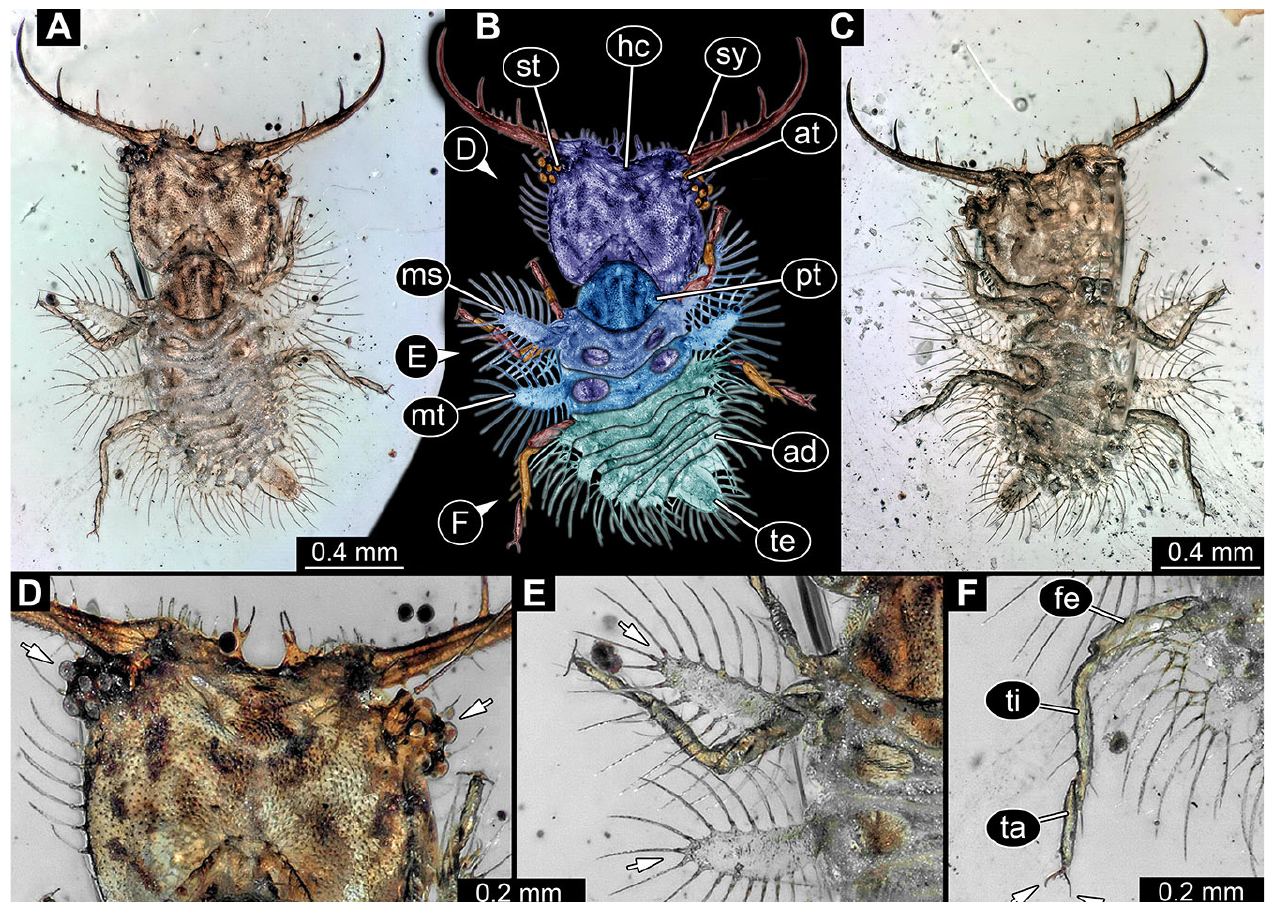
Figure 3. Fossil owllion larva, specimen 3214 (BUB 1430), Cretaceous Kachin amber, Myanmar. ( A ) Overview, dorsal. ( B ) Color-marked version of ( A ). ( C ) Overview, ventral. ( D ) Close-up on head capsule; arrows indicate fields of stemmata. ( E ) Close up on dorsal processes (arrows). ( F ) Close- up on locomotory appendages with claws (arrows). Abbreviations: ad = abdomen; at = antenna; fe = femur; hc = head capsule; ms = mesothorax; mt = metathorax; pt = prothorax; st = stemmata; sy = stylet; ta = tarsus; te = trunk end; ti = tibia.